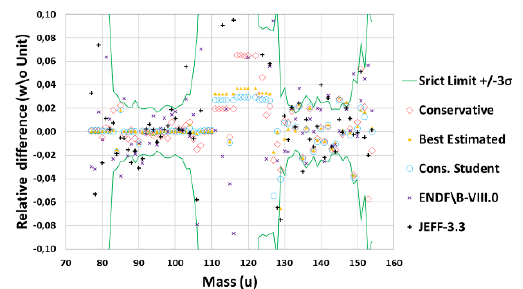
Fig. 18. Relative difference of available evaluations in comparison to the strict one. The green lines correspond to the limits for 99.7% confidence level.